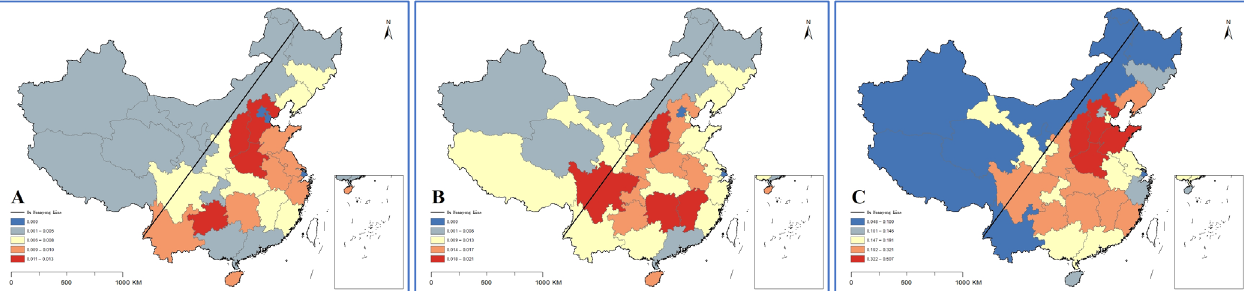
Figure 4. HRDI distribution map of institutions in 2020 (( A ) for county and county-level city medical and health institutions; ( B ) for township hospitals; and ( C ) for village clinics).